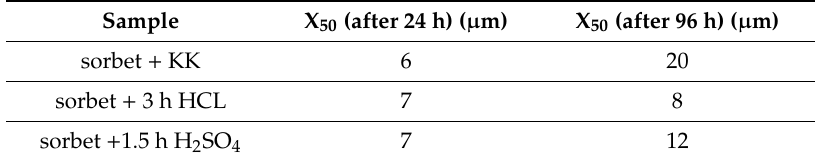
Table 2. X 50 parameter value for strawberry sorbet with the addition of kappa carrageenan and its hydrolysates (value estimated from data presented by Kamińska-Dwórznicka at al. 2015 [1]). Sample